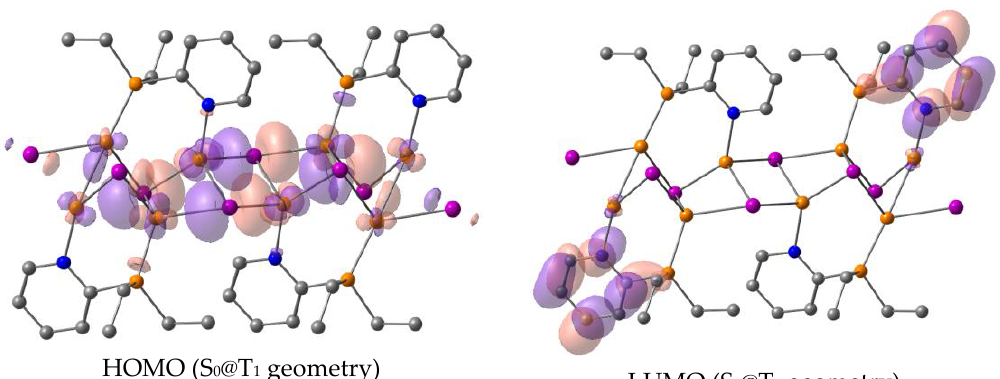
Figure 7. Frontier orbitals of the singlet ground states (S 0 ) for the optimized T 1 (S 0 @T 1 ) geometries of the monomer (top) and dimer (bottom) models (orange – Cu atoms, pink – I atoms, blue – N atoms, grey – C atoms).